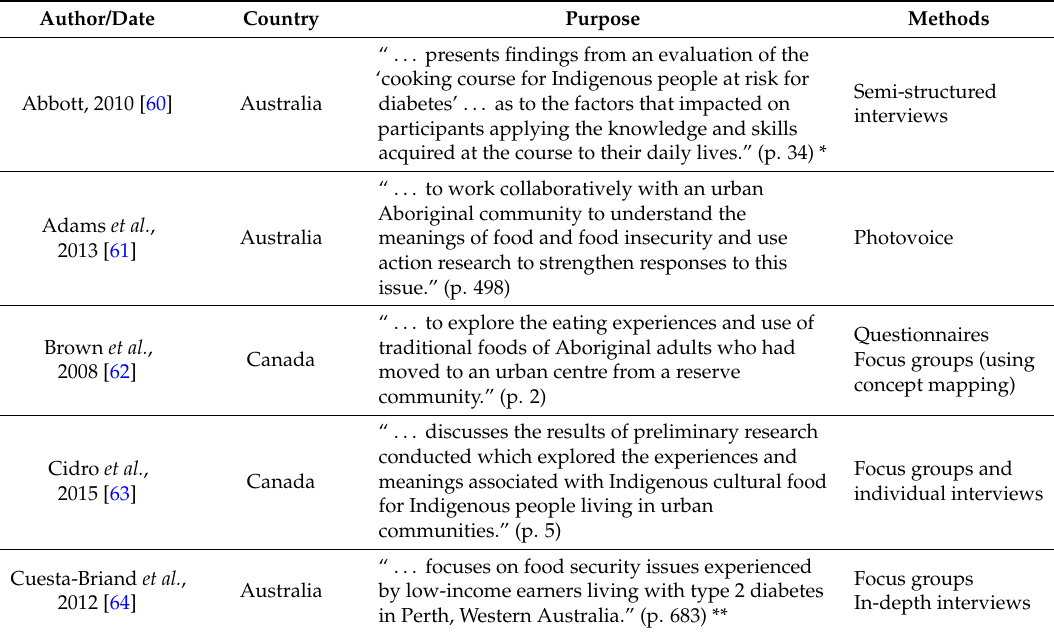
Table 1. Summary of articles included in the